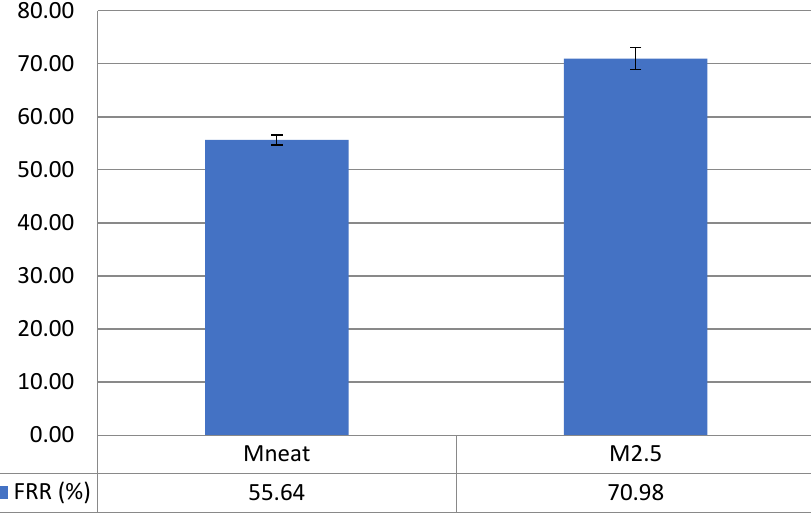
Figure 8. BSA rejection of M2.5, M5.0, and M7.5 AHFM in comparison with MNeat membrane ( n = 3).